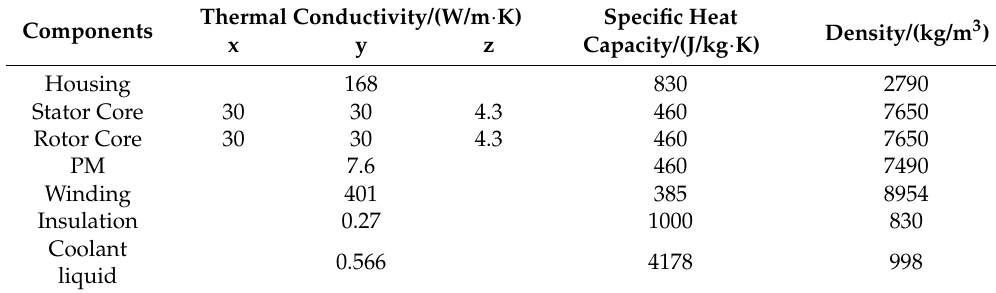
Table 2. Material properties of each component.